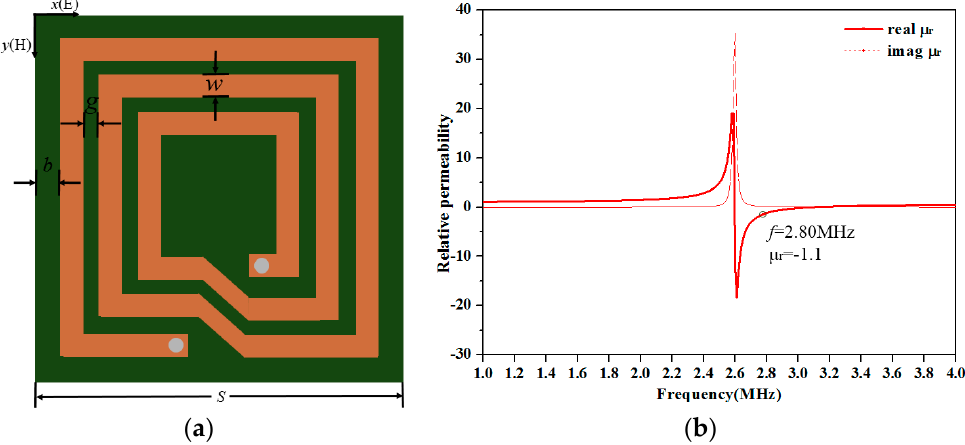
Figure 7. ( a ) The structure of the MM unit cell. ( b ) The relative permeability versus the frequency of the MM unit cell. Table 1. The structure parameters of the MM unit cell.